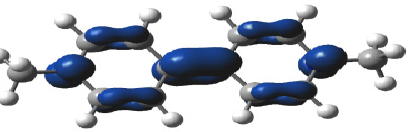
Figure 2. Electron spin distribution of 3 + computed at the B3LYP/6–31+G* level of theory. The examination of this figure indicates that the unpaired electron is not only localized on the electron-rich nitrogen, but it is distributed on all the conjugated pyridine rings and on the C-C connecting bond with resulting system stabilization.